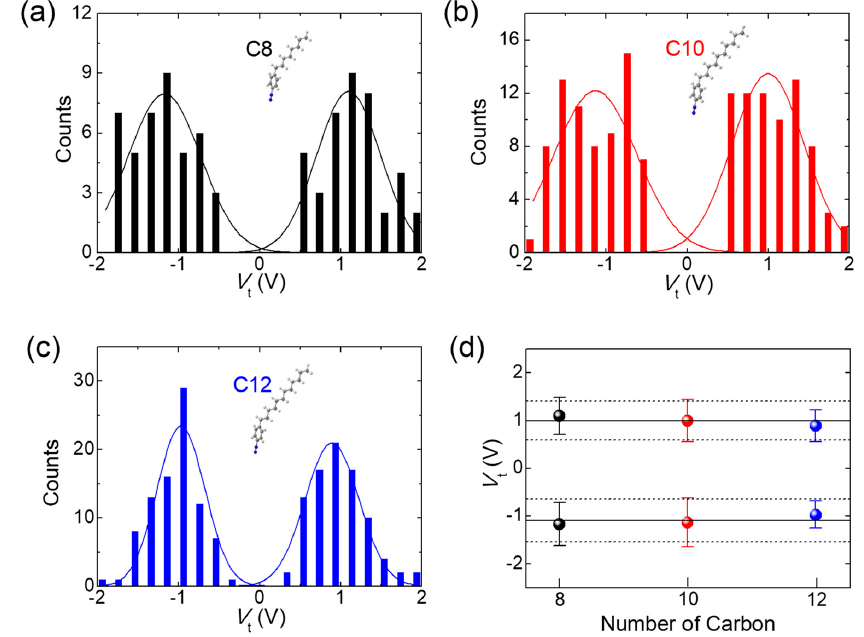
Figure 6. Statistical TVS histograms of ( a ) C8, ( b ) C10 and ( c ) C12 junctions. The solid curves indicate Gaussian distribution, where no significant asymmetry was observed. ( d ) Graphical summary of TVS measurement on the arylalkane junctions. The transition voltage of the junctions was independent of the molecular length.